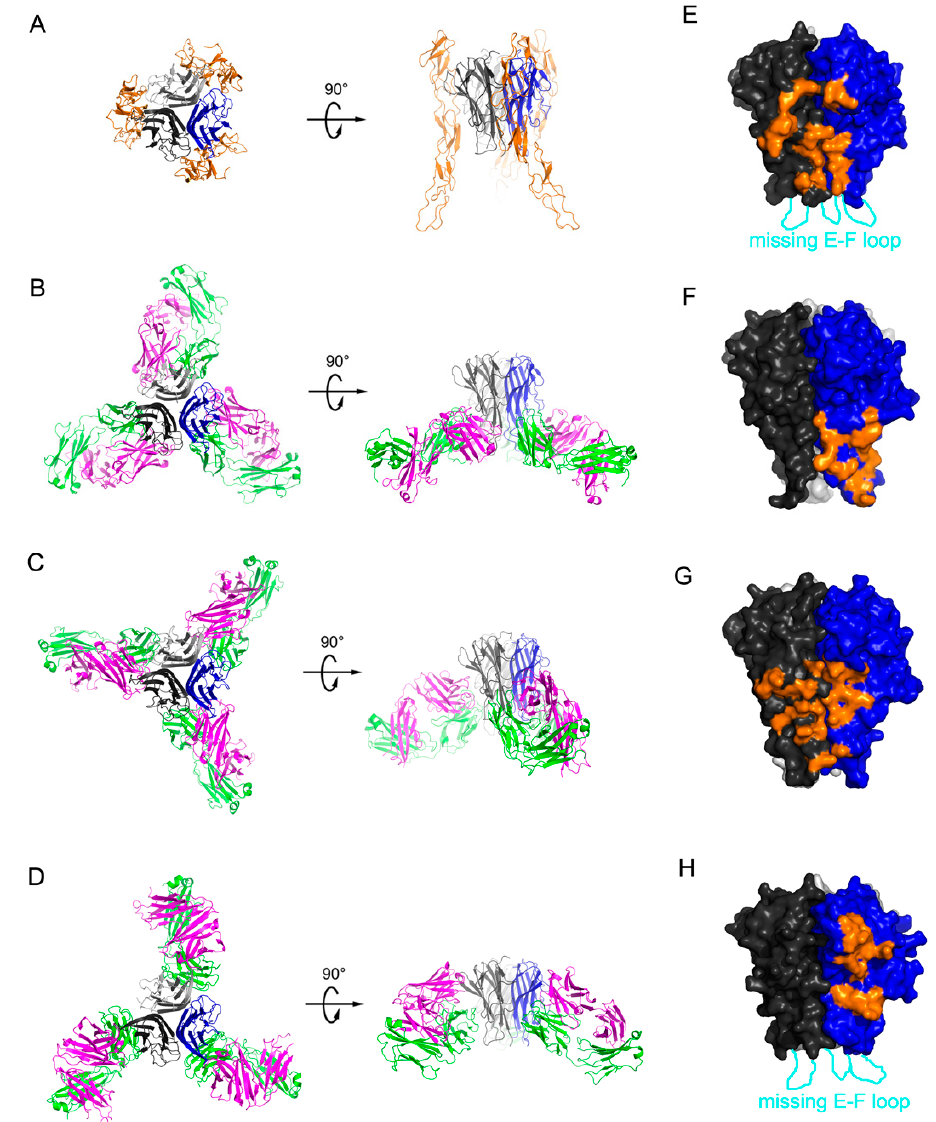
Figure 6. A comparison of the interface between TNF α and the TNF α blockers. ( A ) The structure of the TNF α trimer (black, gray, and blue) in complex with TNFR2 (orange); ( B ) The structure of the TNF α trimer (black, gray, and blue) in complex with the infliximab Fab fragment (heavy chain: purple; light chain: green); ( C ) The structure of the TNF α trimer (black, gray, blue) in complex with the adalimumab Fab fragment (heavy chain: purple; light chain: green); ( D ) The structure of the TNF α trimer (black, gray, blue) in complex with the certolizumab Fab fragment (heavy chain: purple; light chain: green); ( E ) The TNFR2 binding site on the surface of the TNF α trimer (black and blue for each protomer) is colored orange; ( F ) The infliximab epitope on the surface of the TNF α trimer (black and blue for each protomer) is colored orange; ( G ) The adalimumab epitope on the surface of the TNF α trimer (black and blue for each protomer) is colored orange; ( H ) The certolizumab epitope on the surface of the TNF α trimer (black and blue for each protomer) is colored orange. The EF loop, which is missing in the structures of TNF α –TNFR2 and the TNF α -certolizumab complex owing to a lack of interactions, is labeled.